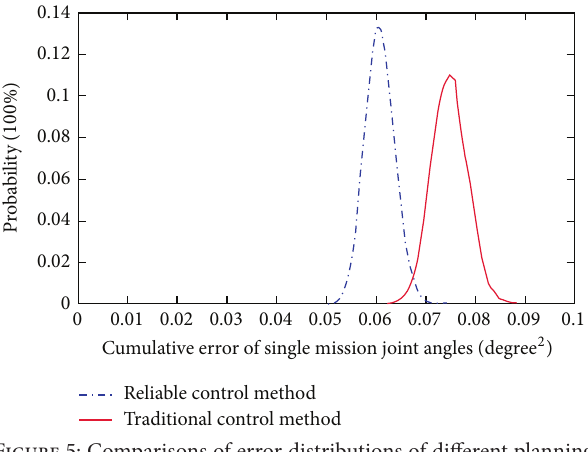
Figure 5: Comparisons of error distributions of different planning scheme.